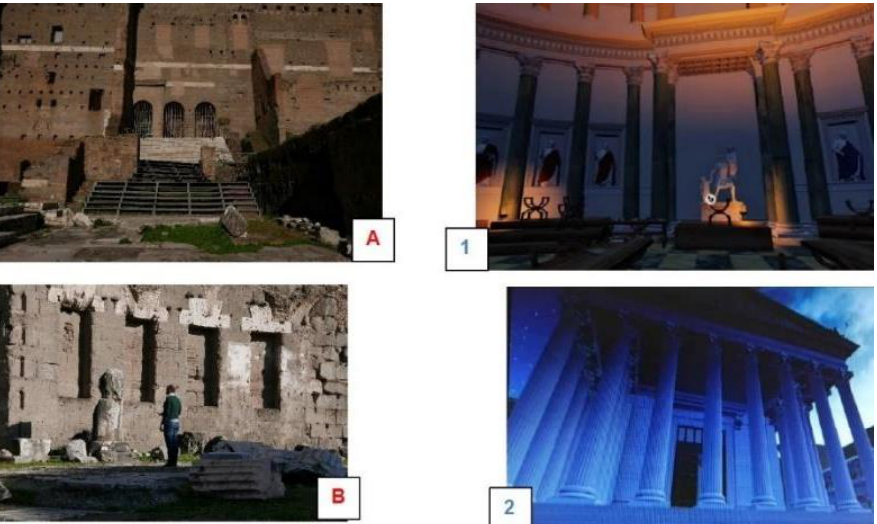
Figure 3. Exercise for pairing photos of archaeological sites and 3D reconstructions. Participants where asked to pair the images archeological sites (eg., ( A ) and ( B )) with 3D reconstructions of the same monuments (eg., ( 1 ) and ( 2 )).